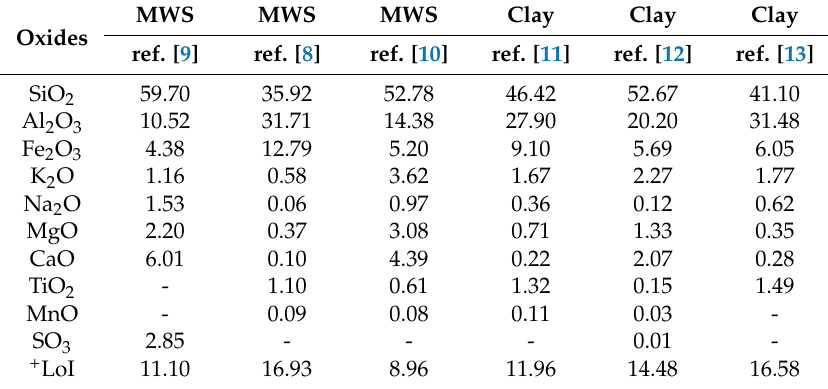
Table 1. Chemical compositions of municipal waterworks sludges and common clays (wt. %).